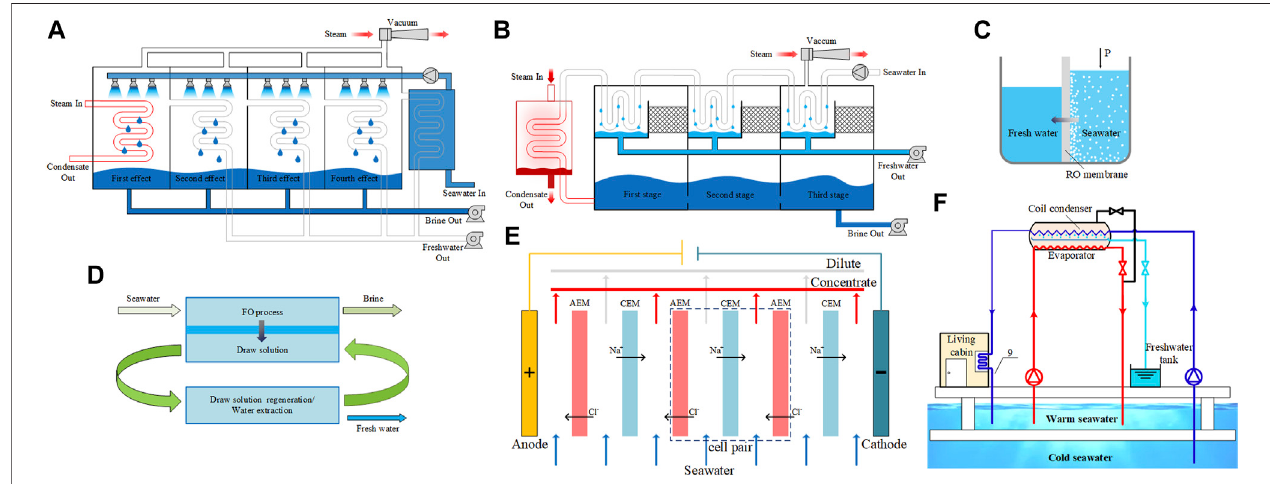
FIGURE 1| Schematic of the seawater desalination process: (A) MED, (B) MSF, (C) RO, (D) FO, (E) ED/EDR, (F) low-pressure fl ash evaporation system powered by ocean thermal energy.